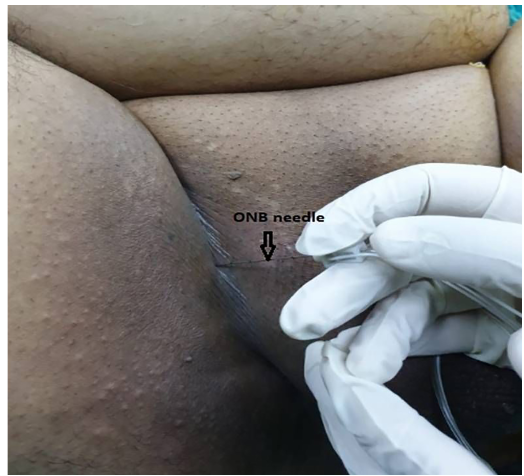
Figure 1 - Demonstration of the position and insertion of the obturator nerve block needle (Obturator nerve blockade prior to the transurethral resection of 3 cm tumoral mass on the right lateral bladder wall of a 63- year-old male